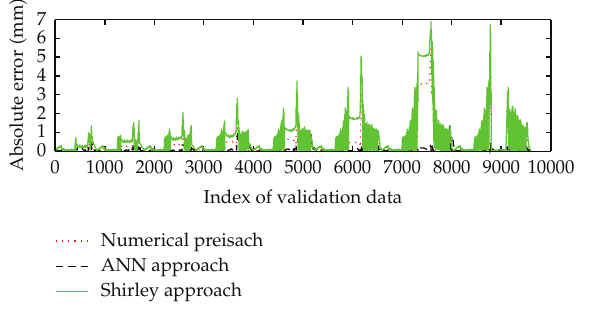
Figure 19: Absolute error of the Classical Numerical Preisach model, the Proposed ANN Model and the Shirley Method in comparison with the first experimental data set.